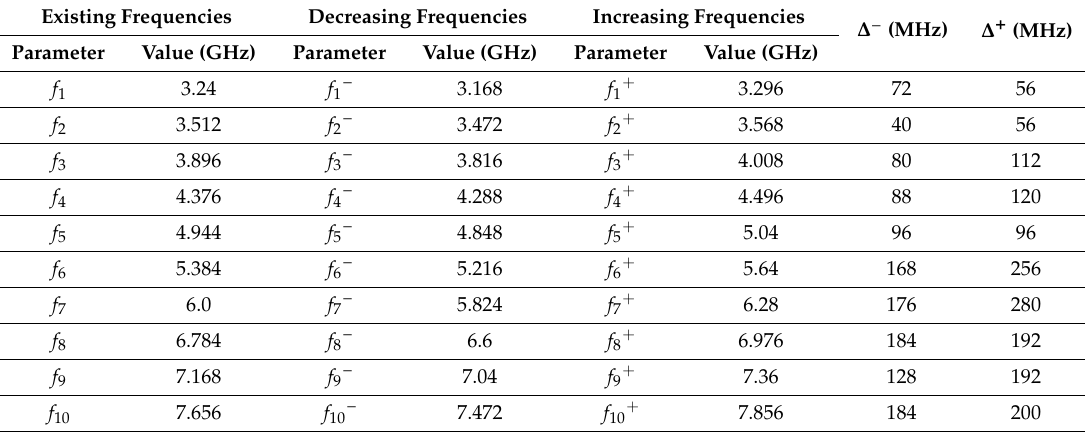
Figure 11. Two simulated S 11 for the proposed tag with length variations. Table 5. The corresponding resonance frequencies of the slot variation resonators.